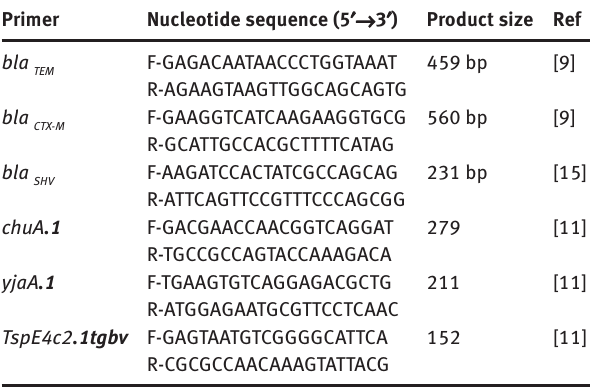
Table 1: Oligonucleotides used in this study. Primer Nucleotide sequence (5 ′→ 3 ′ )